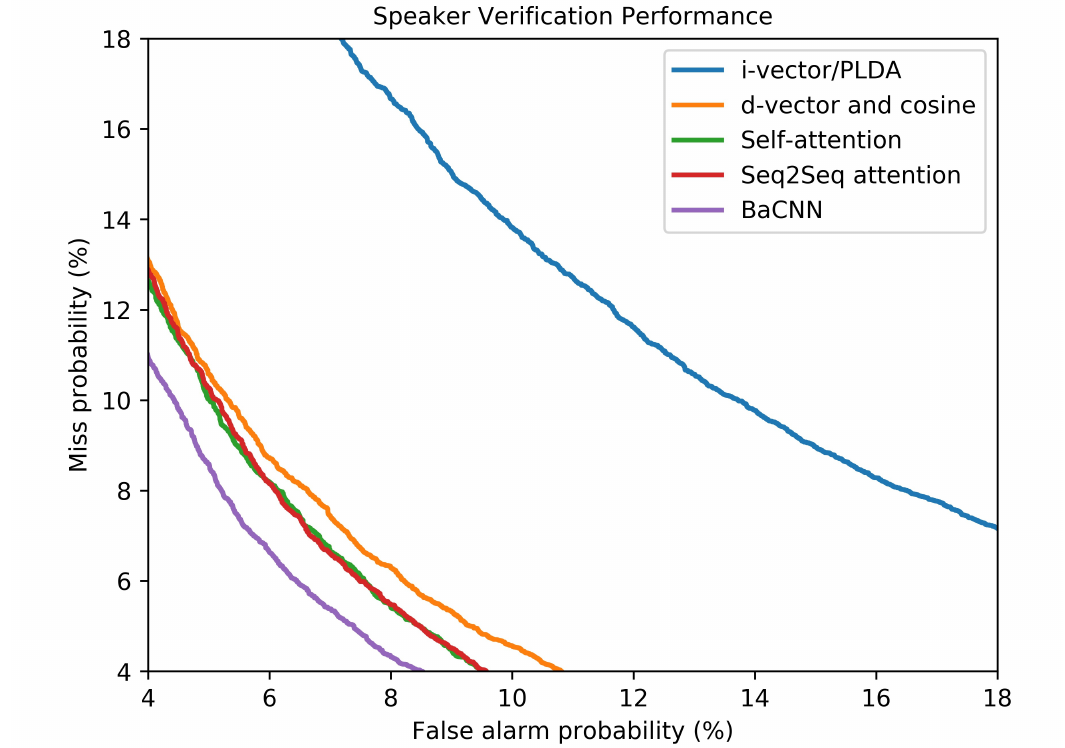
Figure 6. DET curves of different